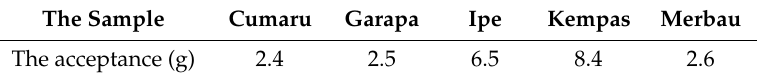
Table 3. The acceptance of wet retardant in